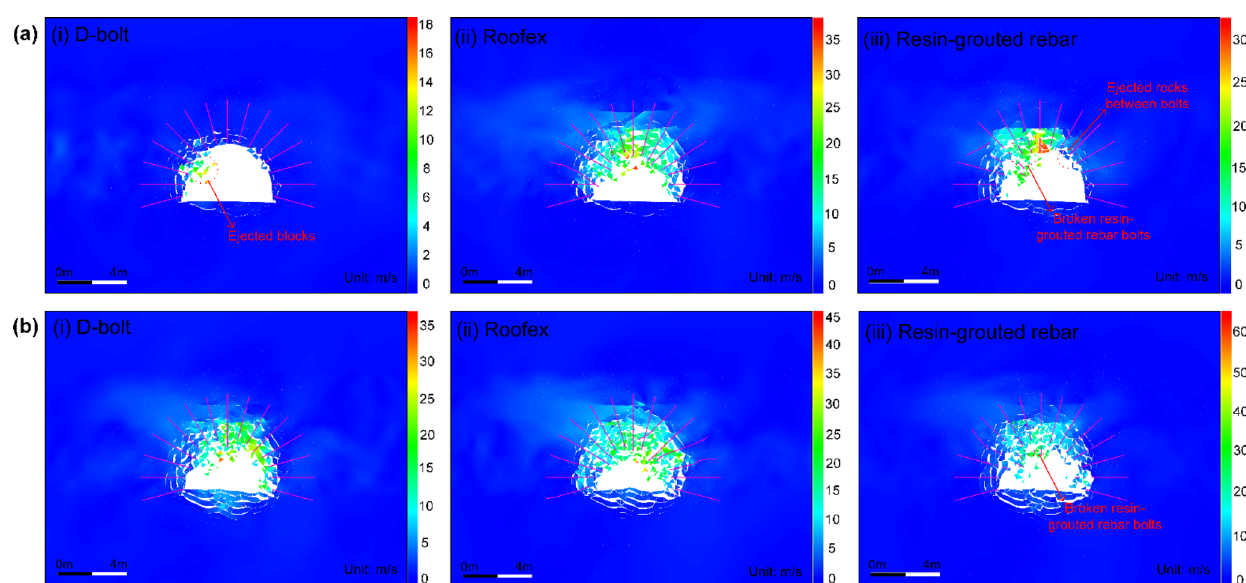
Fig. 14 Simulated velocity distribution of the surrounding rock masses along the tunnel supported by different types of rockbolts. a PPV = 0.2 m/s; b PPV = 0.8 Fig. 15 In-situ observations of broken rebar bolts after rock- bursts in deep tunnels in Canada (photographs taken by authors)